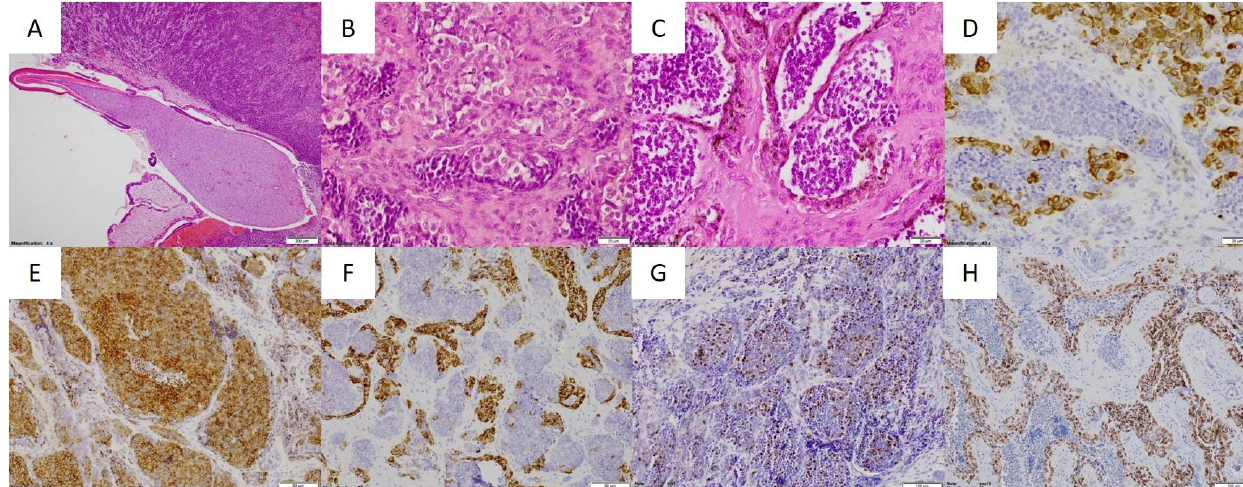
Figure 3. Patient 1: histopathological examination of MNTI. ( A ) Neoplastic tissue surrounding developing tooth with a root resorption (HE, 40×); ( B ) Tumor composed of small hyperchromatic and bigger epithelioid pale cells’ islands embedded in mesenchymal stroma (HE, 400×); ( C ) Nests of small neuroectodermal cells rimmed with brown melanocytic cells (HE, 400×); ( D ) Pan-cytokeratin expression in epithelial population (CKAE1.AE3, 400×); ( E ) Synaptophysin staining with different intensity (synaptophysin, 200×); ( F ) Melanocytic marker HMB-45 within the pigmented cells (HMB-45, 200×); ( G ) Proliferative index up to 15% (Ki-67, 200×); ( H ) SOX10 nuclear expression within the tumor (SOX10, 200×).